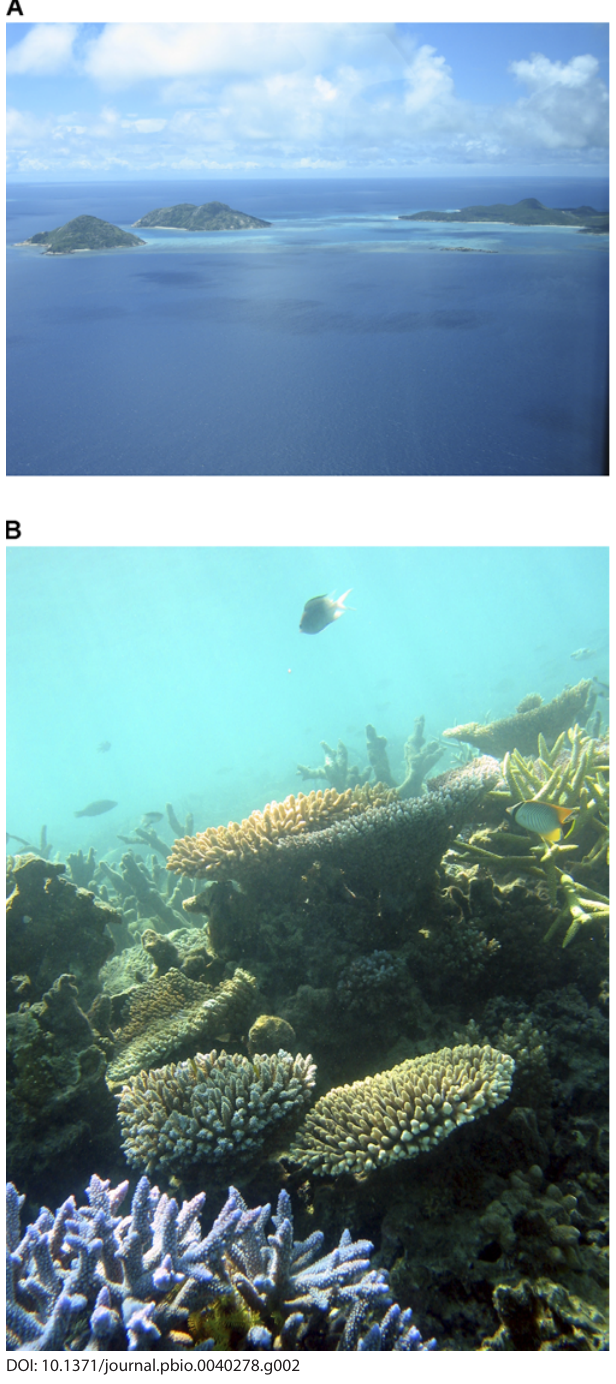
Figure 2. Diverse Coral Reef Systems Serve As Ideal Experiments for Niche and Neutral Theories (A) Surveys of coral reefs on the Great Barrier Reef in Australia, and elsewhere in the Indo-Pacifi c, are prompting both niche and neutral theorists to pay greater attention to the role of environmental fl uctuations on species diversity patterns. Photo courtesy of Sean Connolly. (B) Organisms cover every square inch of coral reef, which led many to believe that their limited potential to partition resources into niches would make them a prime example of neutral dynamics. In fact, species diversity was more variable than would be assumed by neutral theory. Photo courtesy of Terry